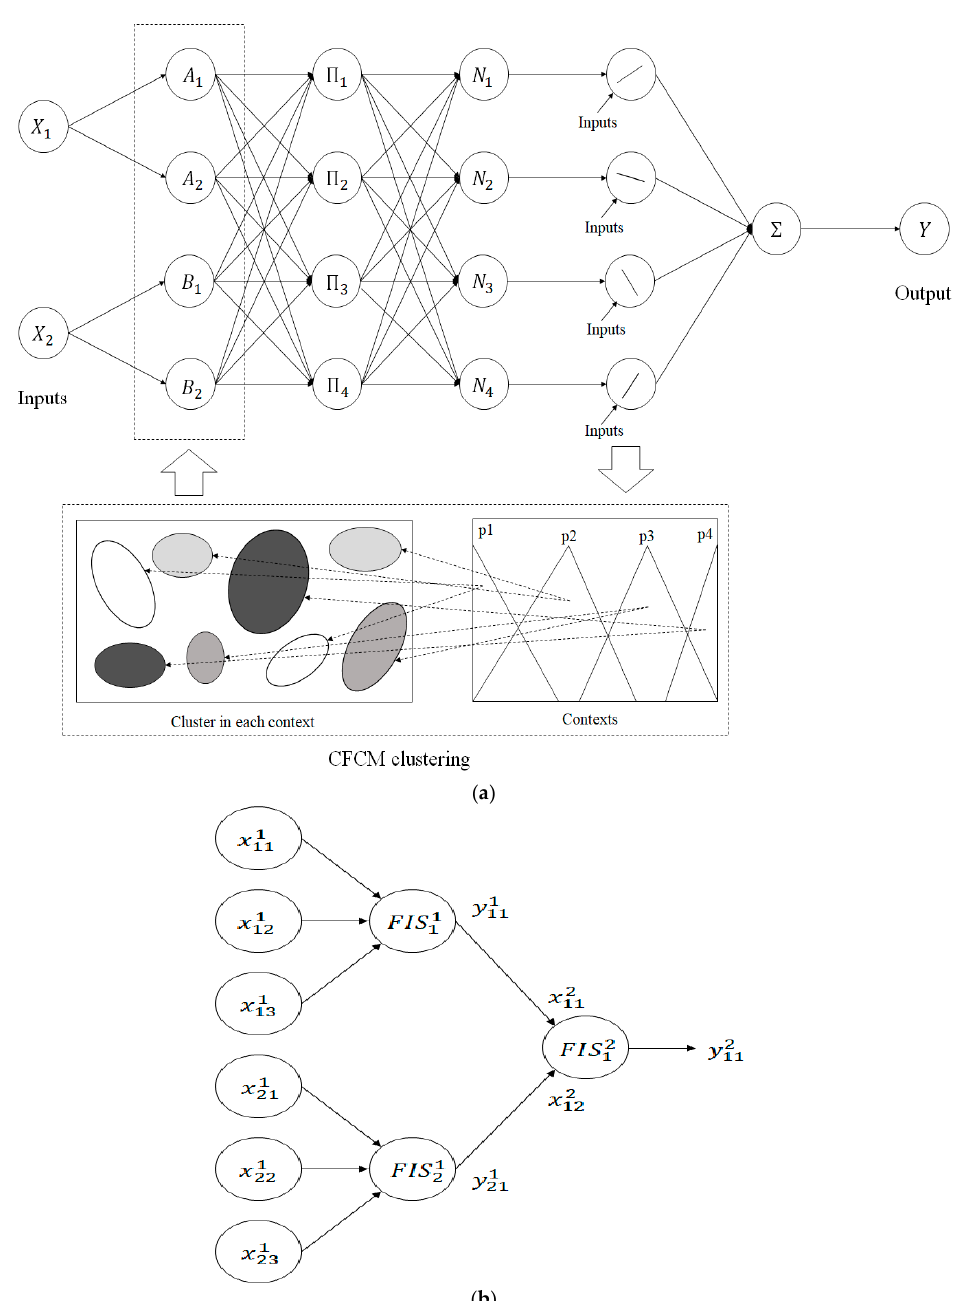
Figure 5. Design of three ANFISs with an incremental tree structure: ( a ) ANFIS structure based on CFCM clustering and ( b ) ANFIS structure based on incremental-tree-structured CFCM clustering.